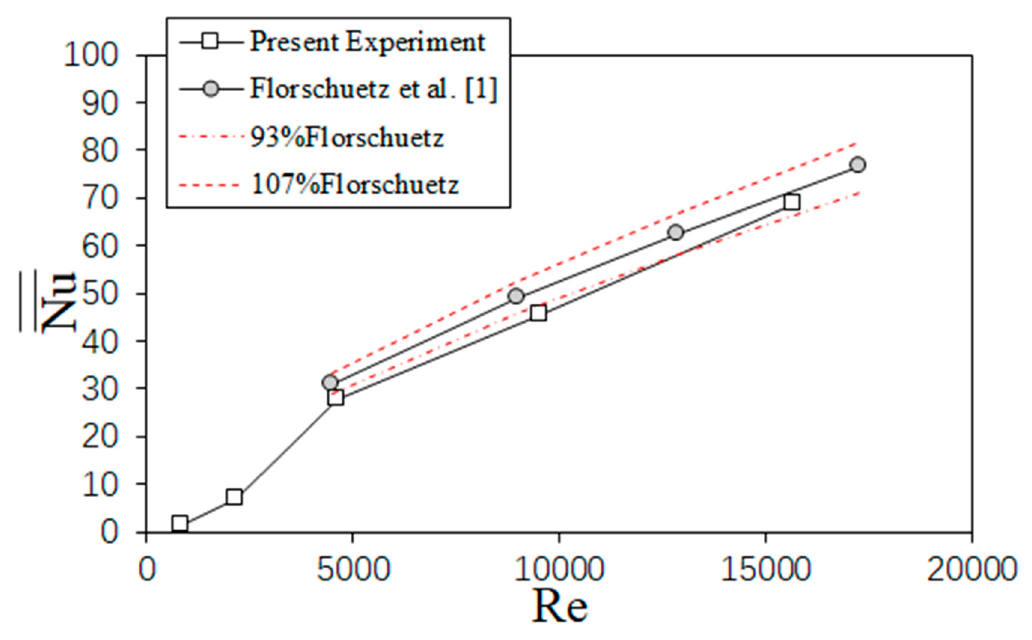
Figure 8. Spatially averaged Nusselt numbers as dependent upon Re, including comparison with impingement jet array correlation from Florschuetz et al. [21].